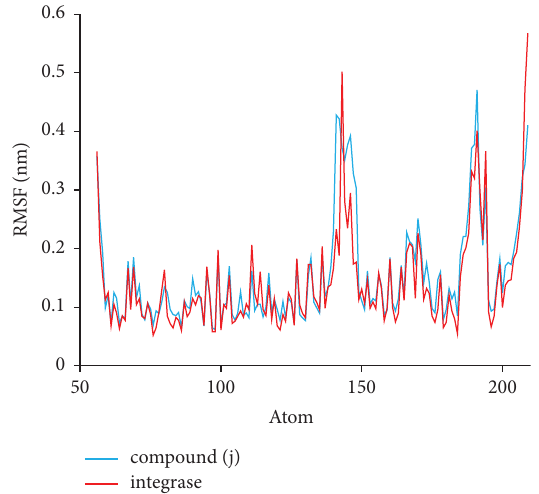
Figure 10: Plot of RMSF changes of alpha carbon integrase according to residue in connection with compound (j) for integrase in red and for integrase in the presence of compound (j) in blue.